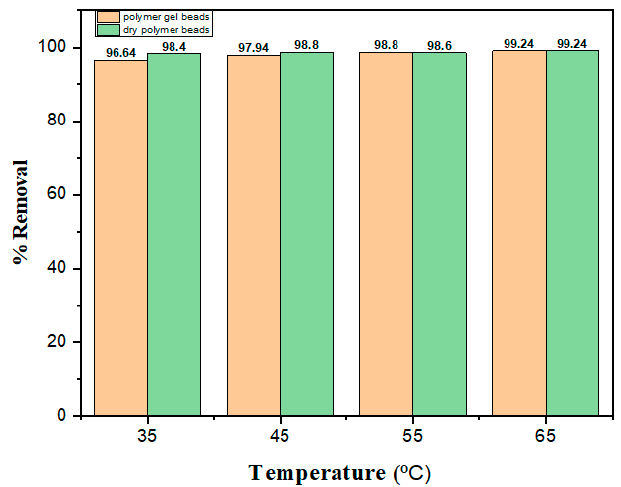
Figure 8. E ff ect of temperature on the removal of MB using polymer gel beads and dry powder beads (concentration of 5 mg L − 1 , pH 6, contact time of 90 min).